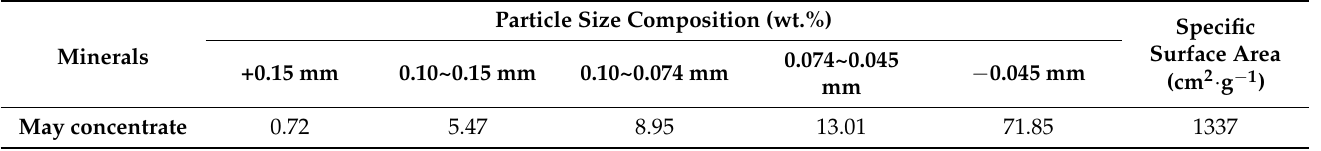
Table 2. Particle size composition of May concentrate iron.